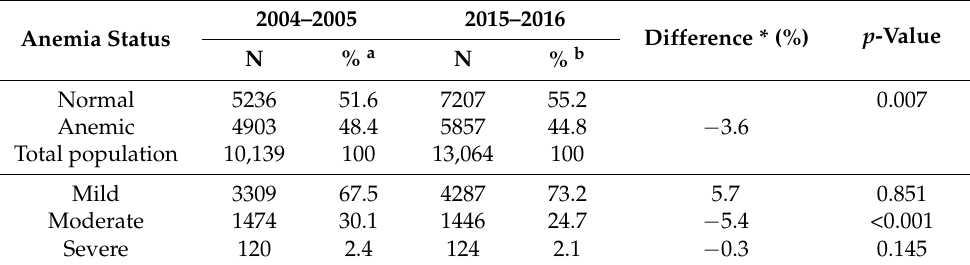
Table 1. The prevalence of anemia among women in